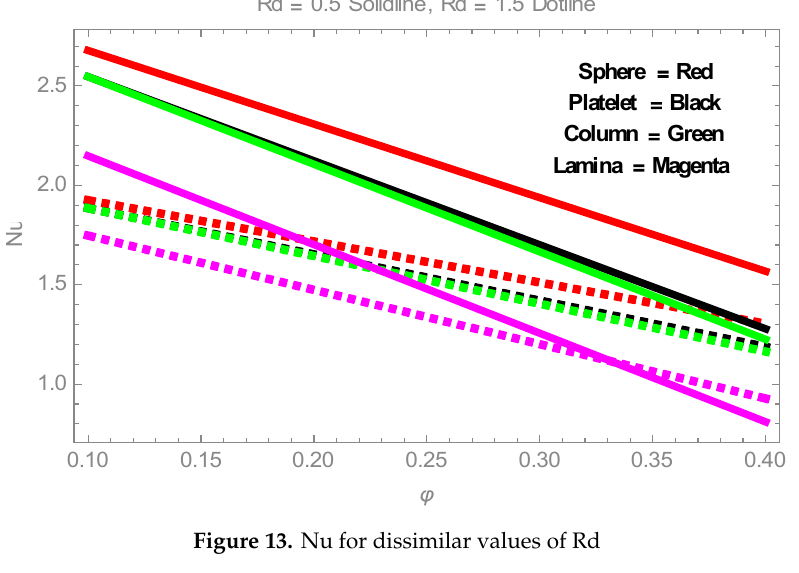
Figure 12. Nu for dissimilar values of (cid:2038).